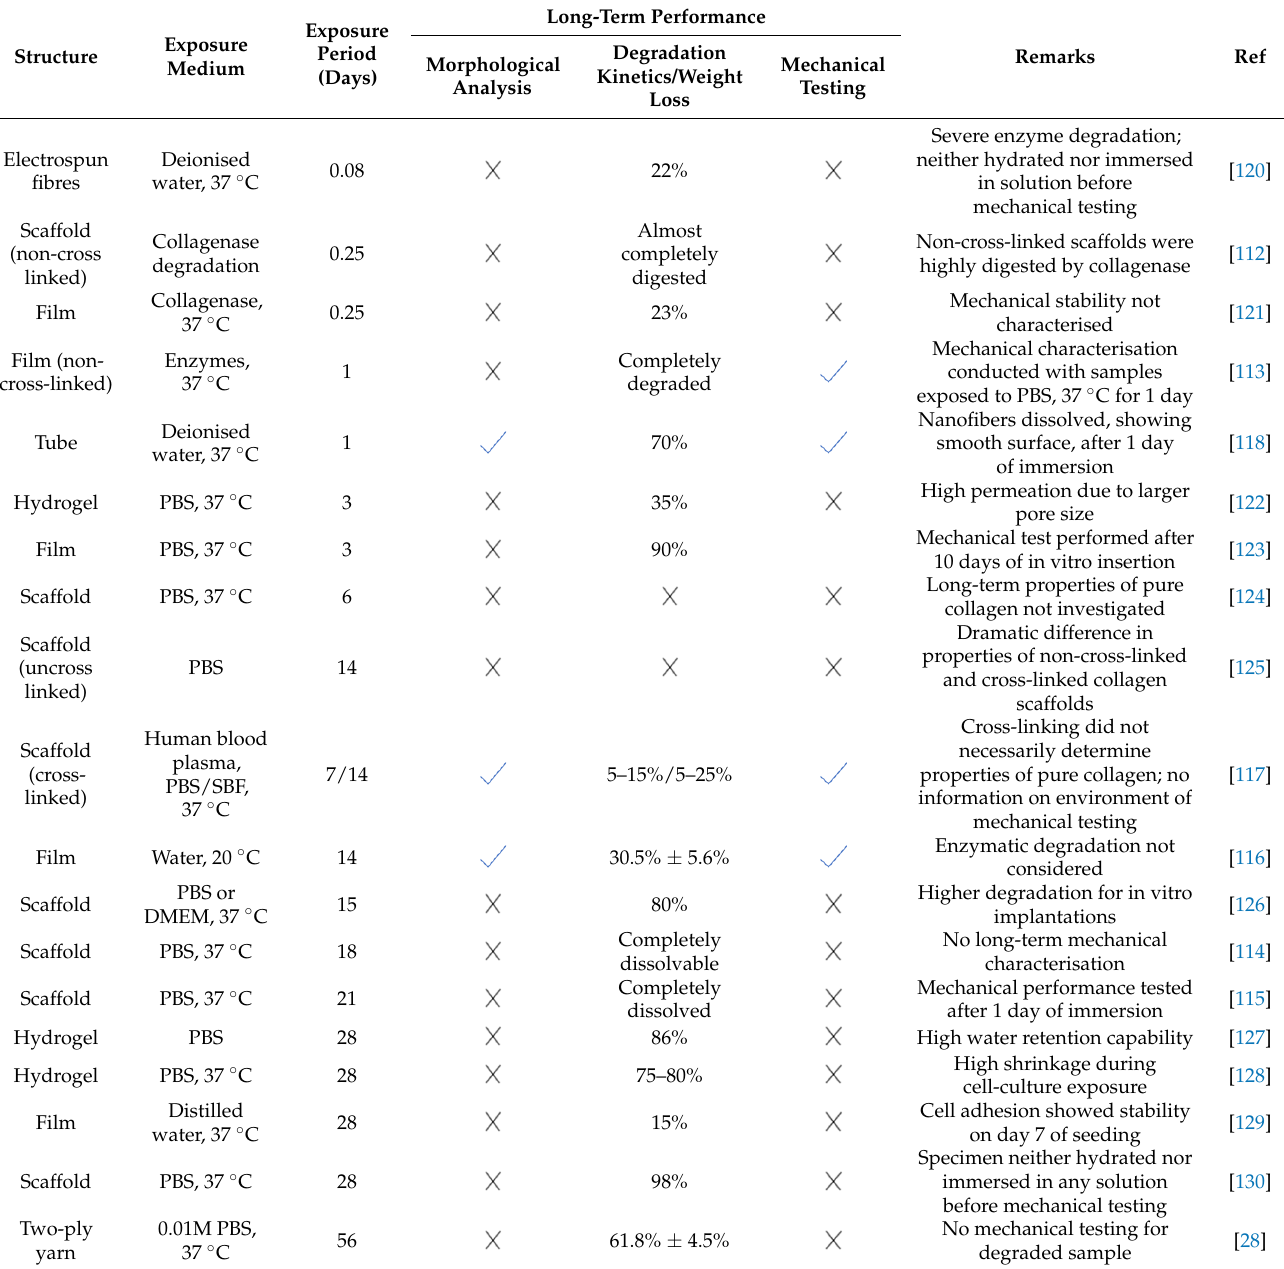
Table 2. Long-term performance of pure engineered collagen (with increasing period of exposure in days).